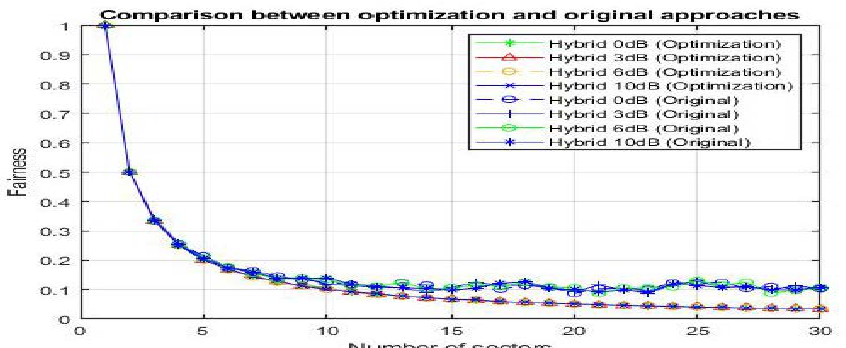
Figure 9. Fairness: comparison between optimization and original approaches by SINR threshold.